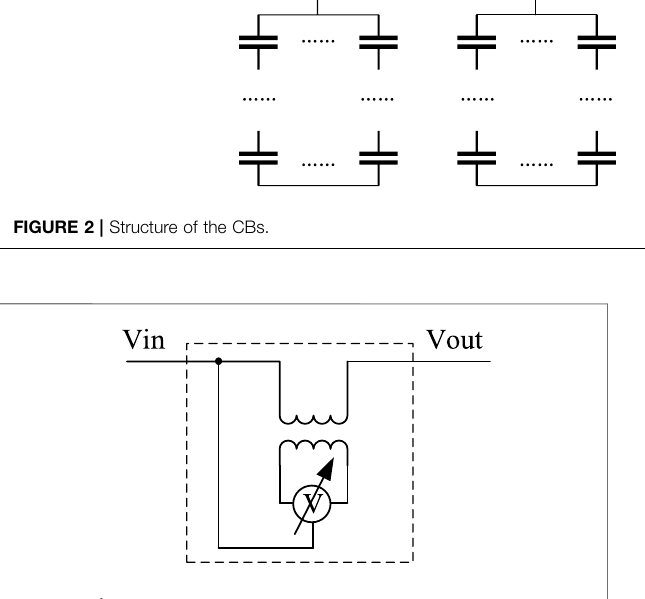
FIGURE 3 | Structure of the